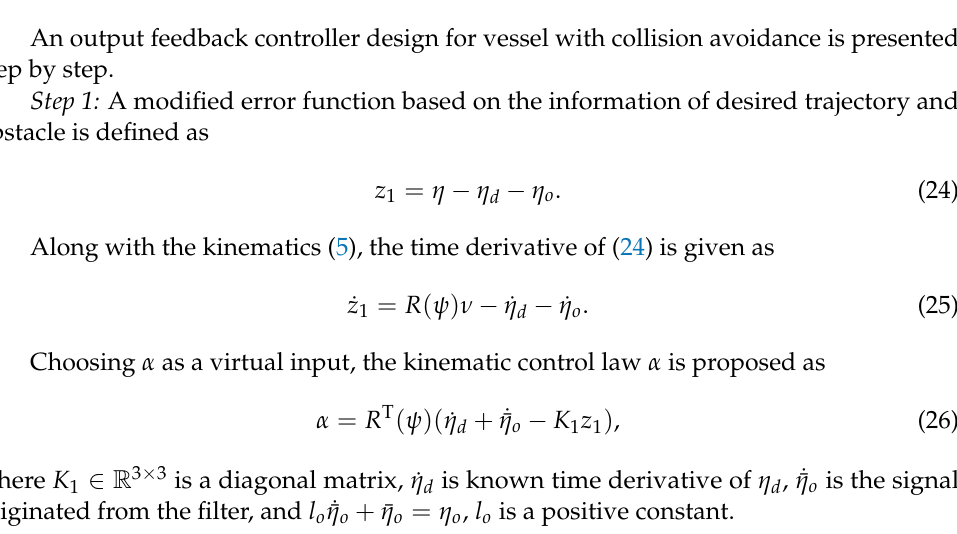
Figure 1. The diagram of the proposed output feedback